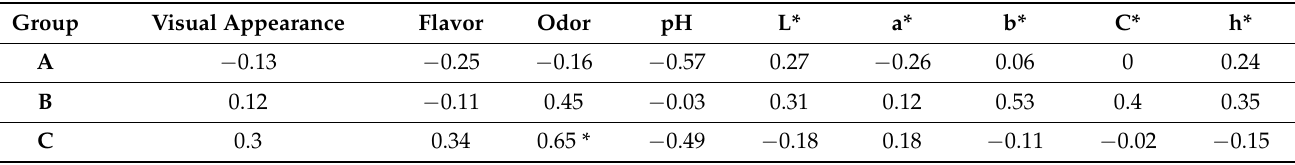
Table 4. Correlation coefficients between safranal content with the sensorial and physicochemical parameters in each group. Group Visual